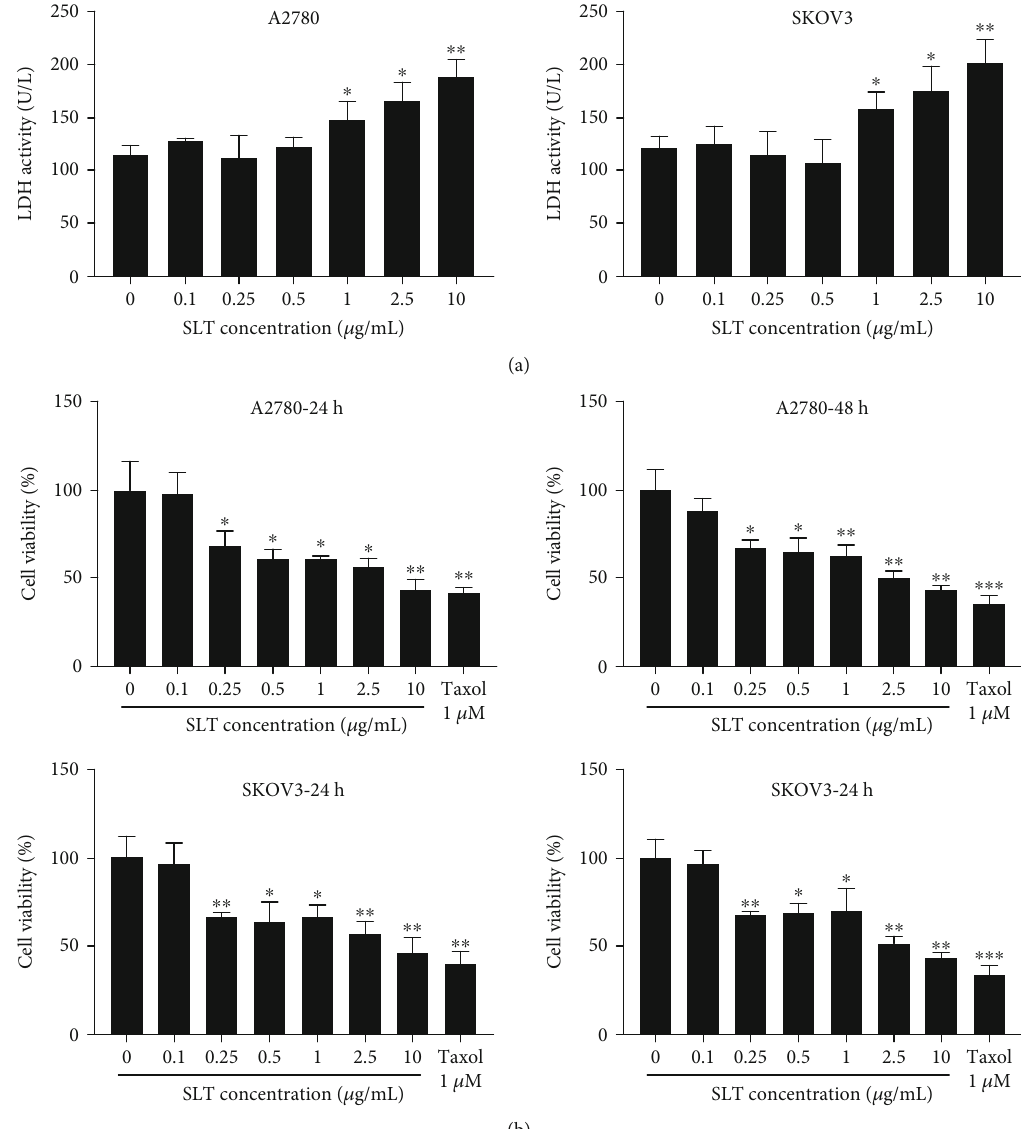
Figure 1: The e ff ects of SLT on ovarian cancer cell viability. (a) The e ff ects of SLT at indicated concentrations on LDH release in A2780 and SKOV3 cells were determined by LDH assay. (b) The e ff ects of SLT at indicated concentrations on the cell viability of A2780 and SKOV3 cells were analyzed by MTT assay. The values were displayed as the mean ± SD . Representative results from three independent experiments were shown ( ∗ P < 0 : 05 , ∗∗ P < 0 : 01 , and ∗∗∗ P < 0 : 001 , compared with the control